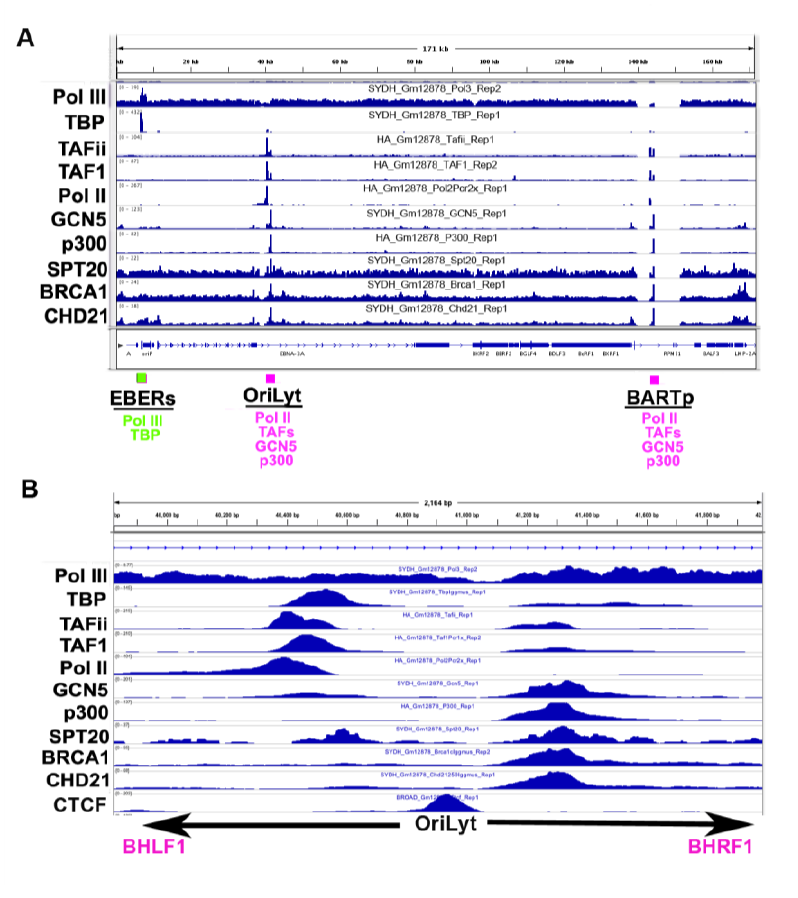
Figure 3. RNA polymerases and transcriptional co-factor occupancy on the EBV genome. ChIP-seq tracks for RNA Pol III, TBP, TAFii, TAF1, RNA Pol II, GCN5, p300, SPT20, BRCA1 and CHD21 for B95-8 LCLs. EBERS oriLyt (R) and BART promoter are indicated below. B) Zoom of the OriLyt region of